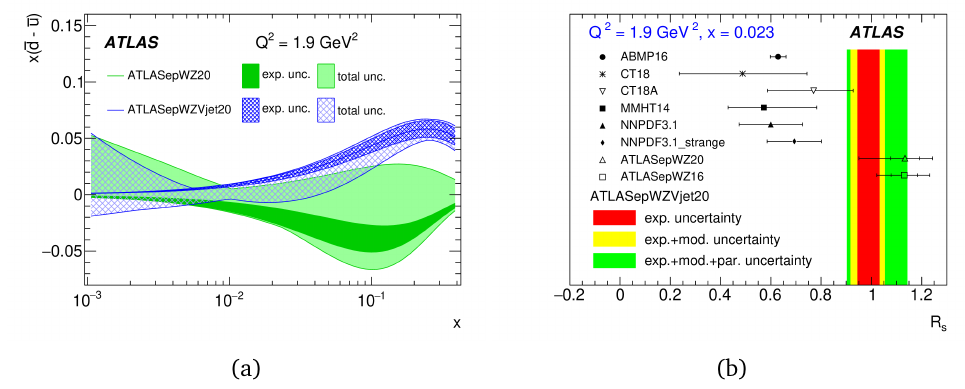
Figure 1: (a) The x ( ¯ d − ¯ u ) distribution evaluated at the starting scale Q 2 = 1.9 GeV 2 as a function of Bjorken- x , extracted from ATLASepWZVjet20 [ 5 ] (blue) and ATLASepWZ20 (green) - an identical fit with V + jets data excluded. (b) R at x = 0.023 and Q 2 = 1.9 GeV 2 , with ATLASepWZVjet20 [ 5 ] compared to other PDF sets. The ATLASepWZVjet20 experimental, model and parameterisation uncertainty bands are plotted